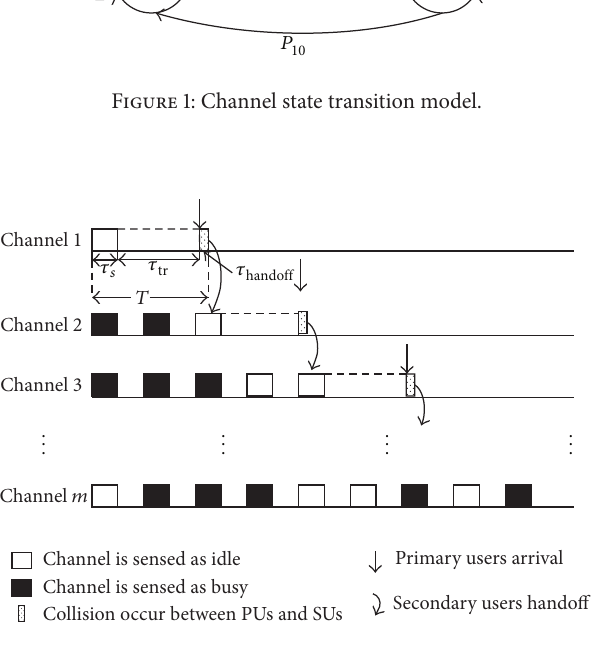
Figure 2: General Dynamic Spectrum Access Scheme for